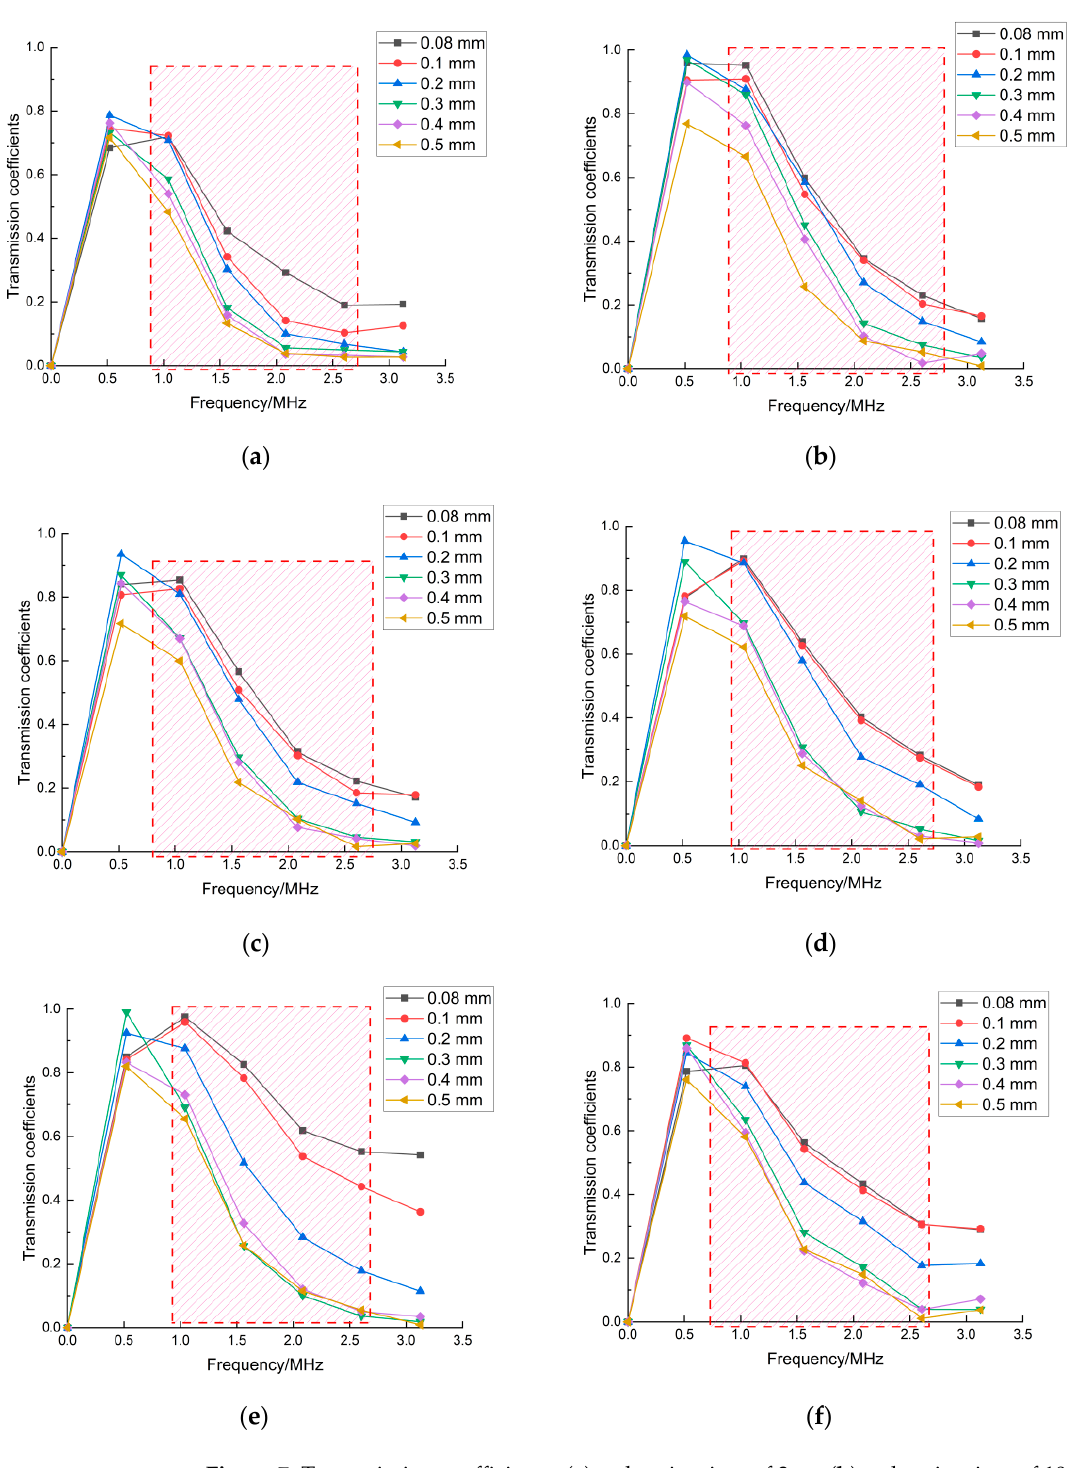
Figure 7. Transmission coefficients: ( a ) pulse-rise time of 3 ns; ( b ) pulse-rise time of 10 ns; ( c ) laser- source power of 0.5 MW; ( d ) laser-source power of 0.7 MW; ( e ) laser-source radius of 80 mm; ( f ) laser-source radius of 120 mm.